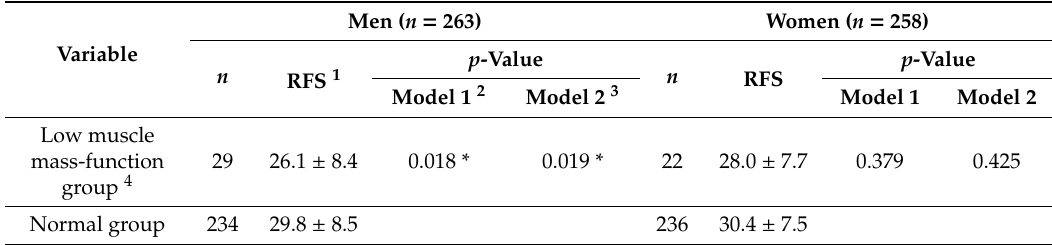
Table 4. Recommended food score (RFS) values according to the muscle mass-function